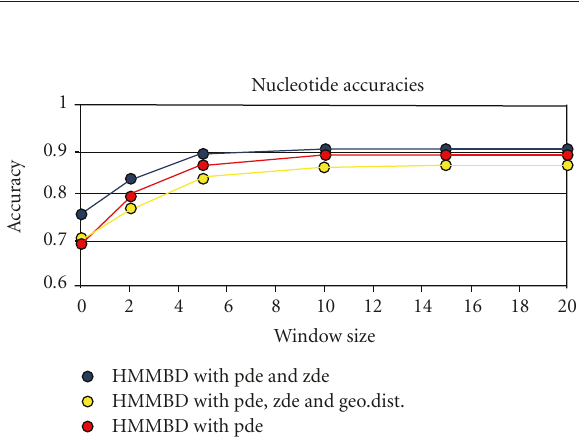
Figure 4: Nucleotide level accuracy rate results for three di ff erent kinds of